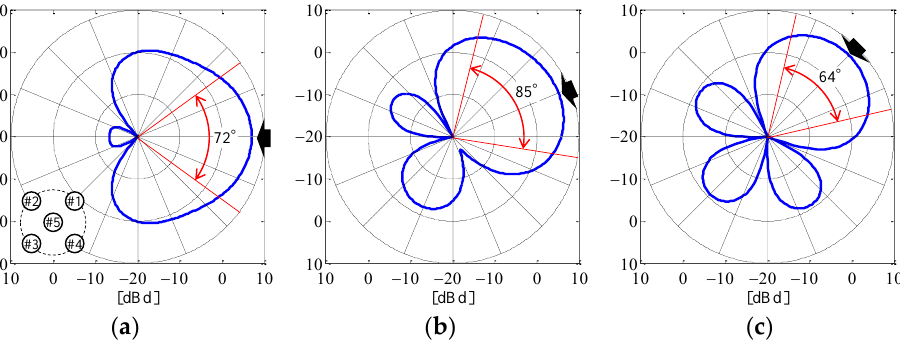
Figure 11. Radiation beam based on Table 1 in the xy -plane: ( a ) ϕ = 0°; ( b ) ϕ = 22.5°; and ( c ) ϕ = 45°.